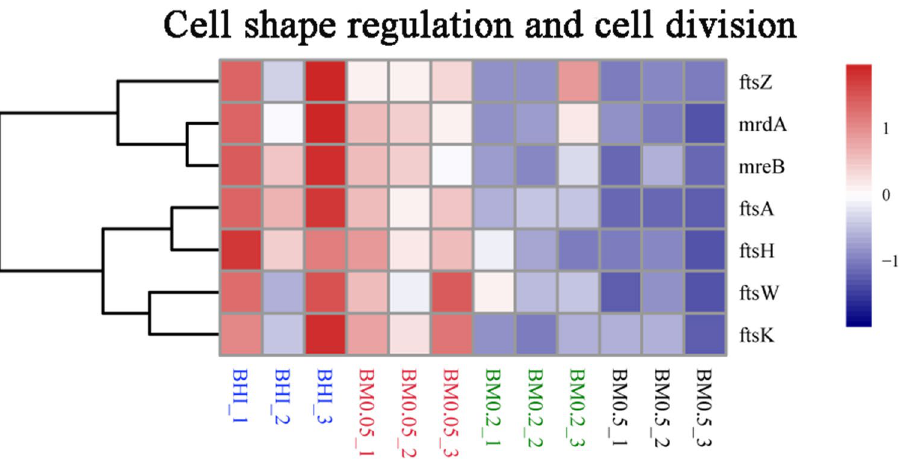
Figure 5. Heatmap analysis of genes related to cell